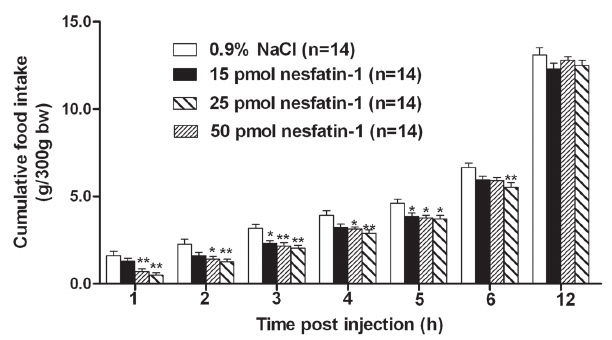
Figure 1. Nesfatin-1(15, 25, or 50 pmol) injected into the dorsal vagal complex (DVC) decreased dark phase food intake in rats. Cumulative food intake was monitored for 12 h after injection. Each bar represents the mean 6 SEM. *P , 0.05; **P , 0.01 vs. vehicle.